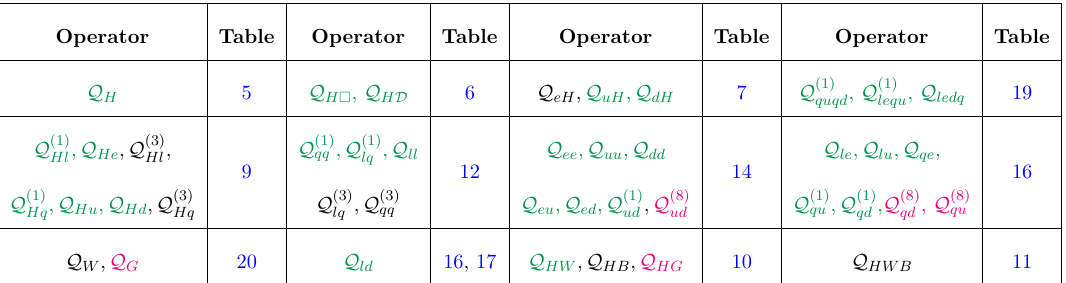
Table 24 . SMEFT dimension-6 effective operators unfolded by minimal extension. The operators in black are generated by the H the extra operators highlighted in pink color. The ones shown in green are common to both these new